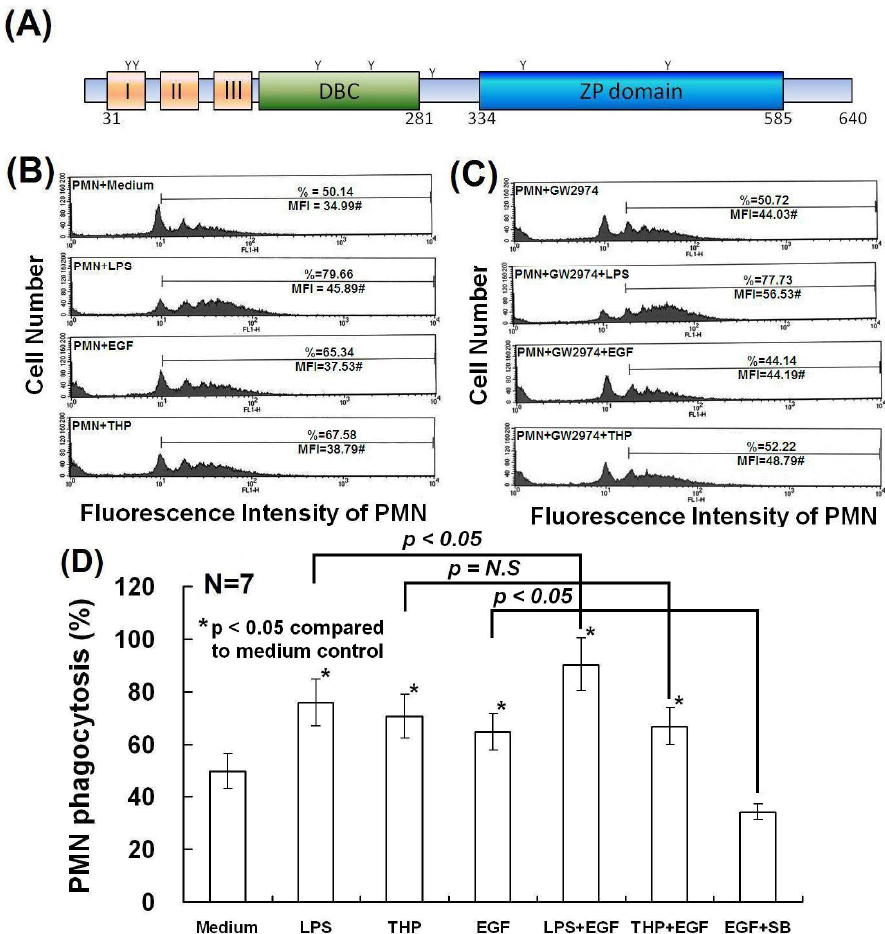
Figure 6. A schematic domain structure of the THP protein core and the effect of recombinant human EGF (20 ng/mL) and EGFR inhibitor GW2974 (0.25 μ M) on PMN phagocytosis. ( A ) Domain structure of THP’s protein core. Black box: leader peptide; orange boxes: EGF-like domains; green box: D8C domain; blue box: ZP domain. The 7 N-glycosylation sites are marked as Y. ( B ) PMNs were activated by LPS, EGF, or THP for 30 min, and then PMN phagocytosis was detected by flow cytometry. ( C ) PMNs were pretreated with GW2974 (0.25 μ M) for 20 min followed by stimulation with LPS, EGF, or THP for 30 min. PMN phagocytosis was detected by flow cytometry. ( D ) Comparison of PMN phagocytosis among different treated groups. * denotes p ≤ 0.05 compared to medium control. It is worthy to note that (LPS+EGF)-induced PMN phagocytosis is higher than LPS alone ( p < 0.05) whereas (THP+EGF)-induced phagocytosis is not different from THP